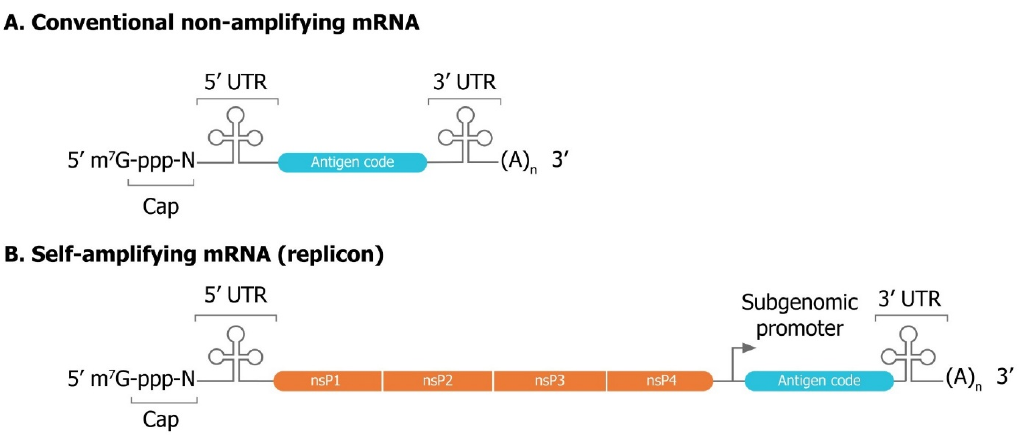
Figure 4. A comparison of mRNA vectors. Both conventional ( A ) and self-amplifying ( B ) mRNAs share basic elements including a cap, 5 ′ UTR, 3’ UTR, and poly(A) tail of variable length. Self ‐ amplifying RNA (saRNA) also encode four non-structural proteins (nsP1–4) and a subgenomic promoter derived from the genome of the alphavirus. nsP1–4 encode a replicase responsible for amplification of the saRNA that enable lower doses than non-replicating mRNA.